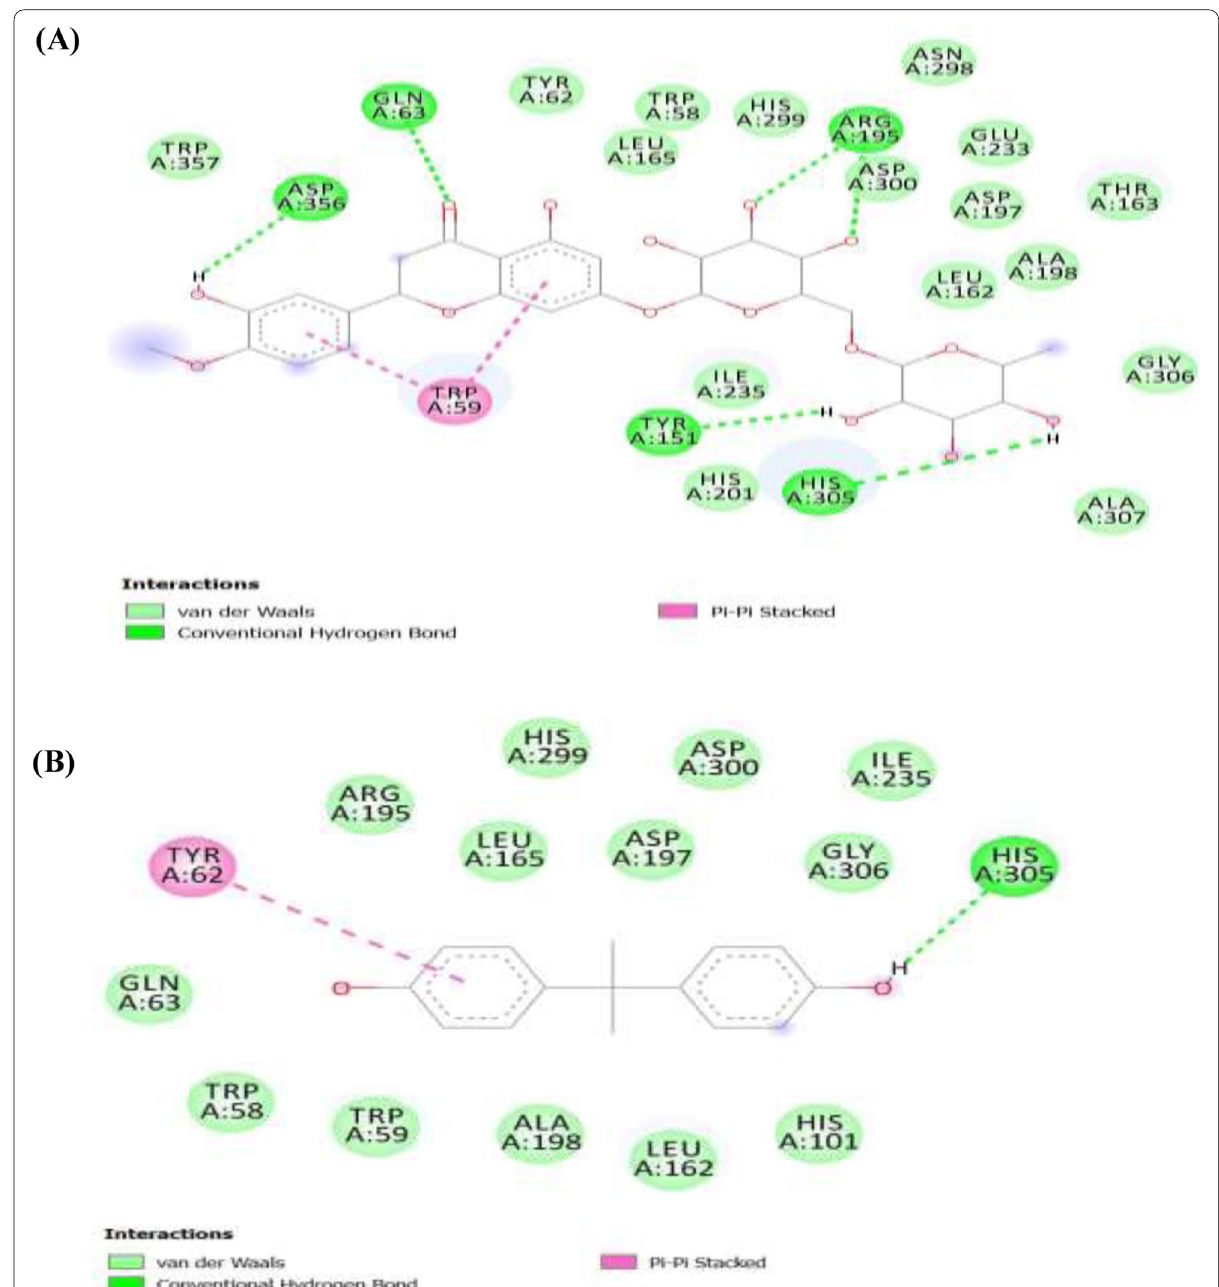
Fig. 9 α - glucosidase ligands interaction. (A) . Hesperidin. (B) . Bisphenol A. Dark green: conventional hydrogen bond; light green: van der Waals; Pink: π-π